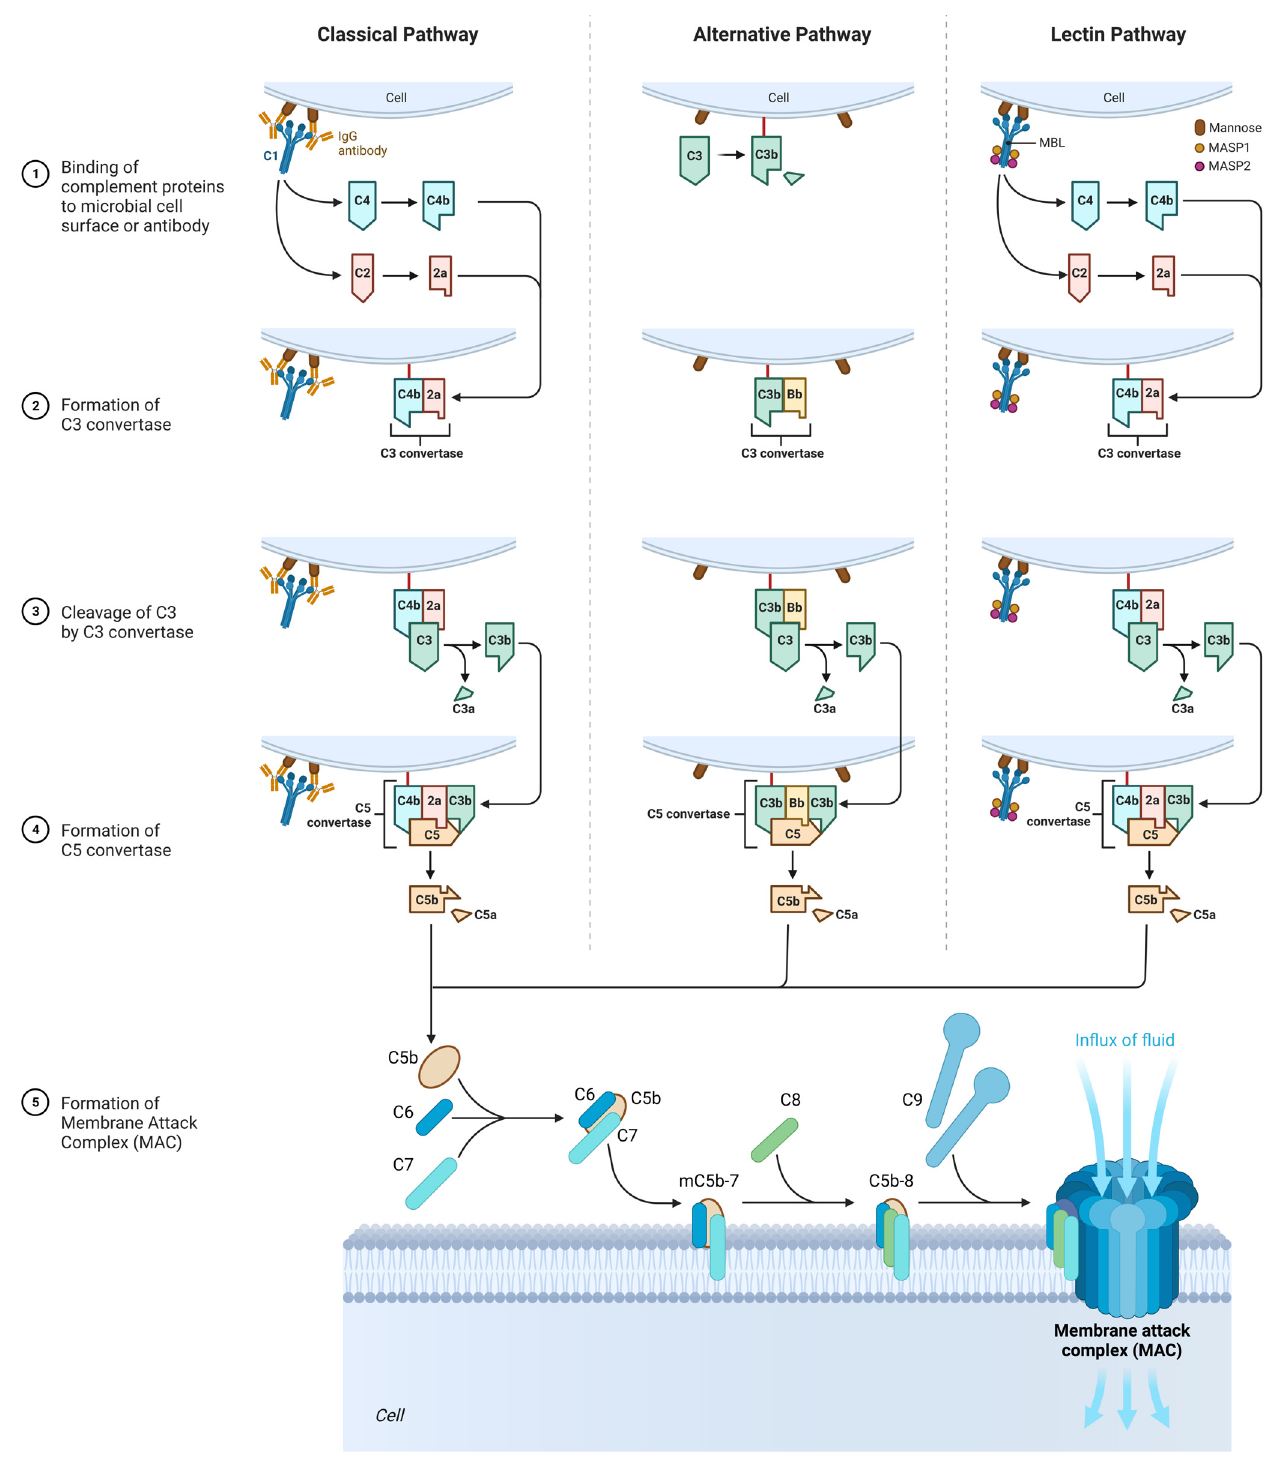
Figure 5. The role of the complement system in the SFP mechanism. Classical pathway: C1 component of complement cleaves C4 and C2 into two fragments. C3 convertase is formed. Under the action of C3 convertase, C3a will be formed. C3a, being an anaphylotoxin, will lead to the basophil degranulation. At the end, MAC is formed that leads to cellular damage. Alternative pathway: C3 spontaneously decomposes to C3a and C3b. After that, C3bBbP complex is formed (C3 convertase of the alternative pathway), and more C3 decomposes to C3a and C3b. The end step is MAC formation. Lectin pathway: All the characteristics are similar to those in classical pathway, except initiation factor. In this case, initiation factor is MBL.